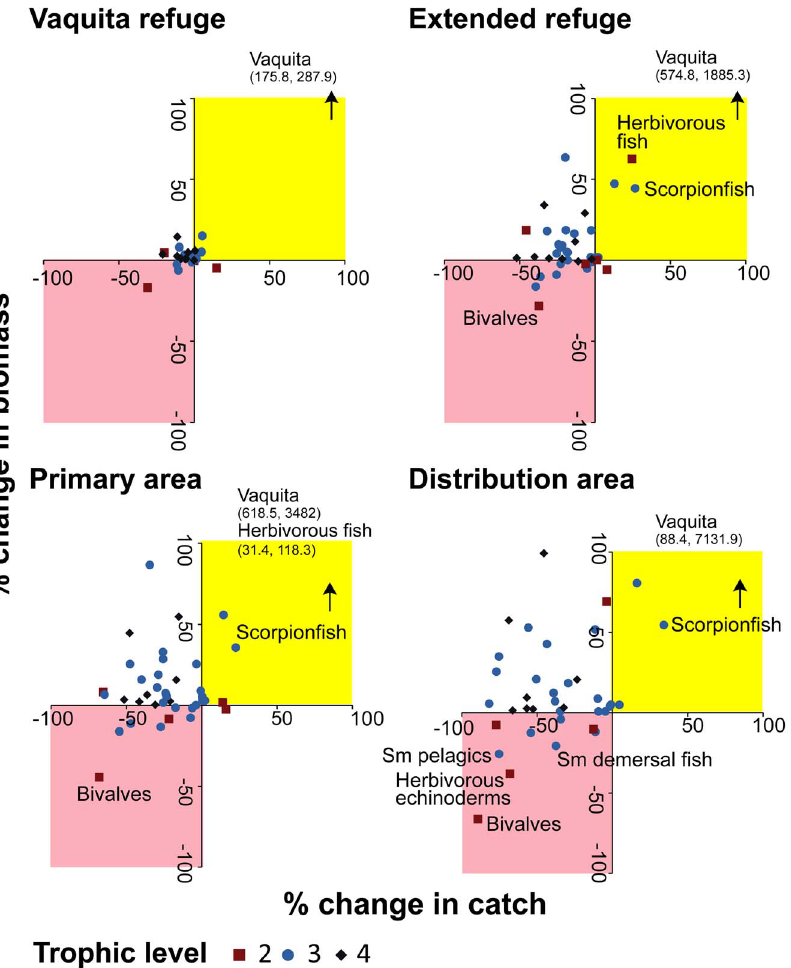
Figure 5. Percent change in catch and biomass for each management scenario relative to the No vaquita management scenario in 2038. Species are binned by trophic level as indicated by the markers. We indicate groups with . 6 20% change in both catch and biomass. The pink shading indicates species with aa decrease in both catch and biomass. The yellow shading indicates species withan increase in both catch and biomass. The arrows indicate the groups that are off the scale.